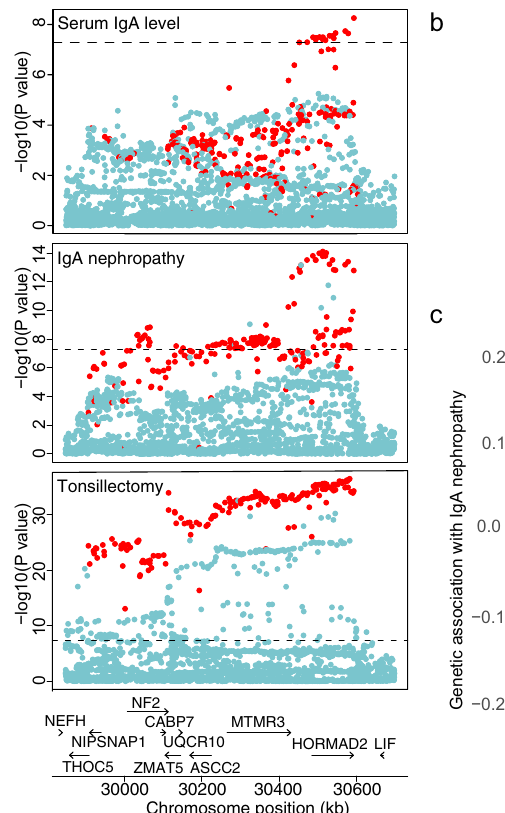
Fig. 5 | Colocalization and Mendelian randomization analyses based on GWAS forserumIgAlevels,IgAnephropathyandtonsillectomy.a Regionalplotofthe HORMAD2/LIF locus for IgA levels (without the deCODE-Lund cohort, top panel), IgA nephropathy (middle panel), and tonsillectomy (lower panel). The two-sided unadjusted P -value corresponds to the fi xed effects GWAS meta-analysis. b Co-localization analysis of HORMAD2/LIF locus across the three traits; PP4 is the posterior probability of co-localization. c Mendelian randomization analysis using